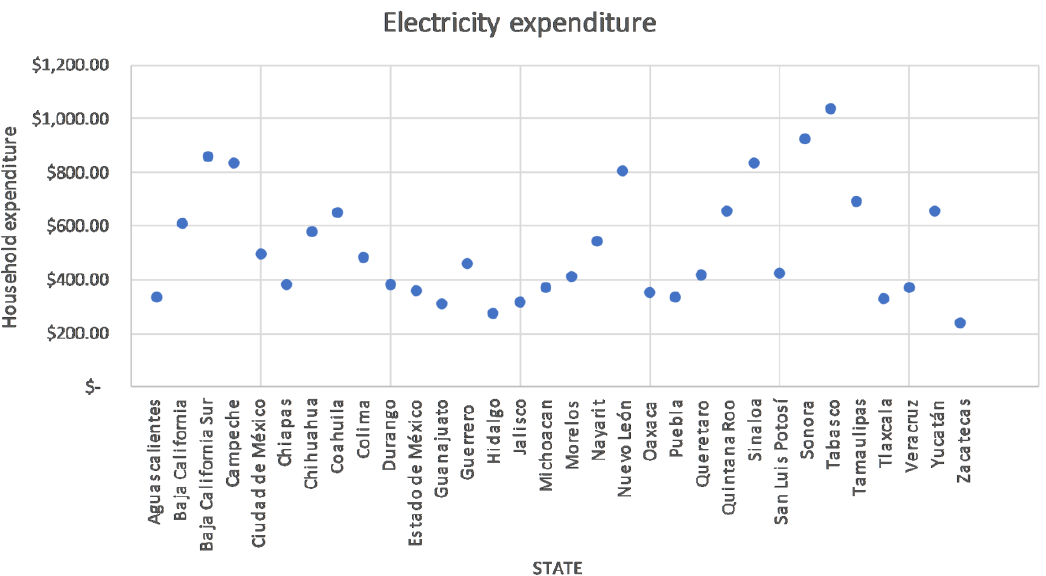
Figure 2. Average bimonthly electricity expenditure per household in pesos, by State. In Mexico, payment for domestic electric service is made every two months. Source ENCEVI, INEGI.